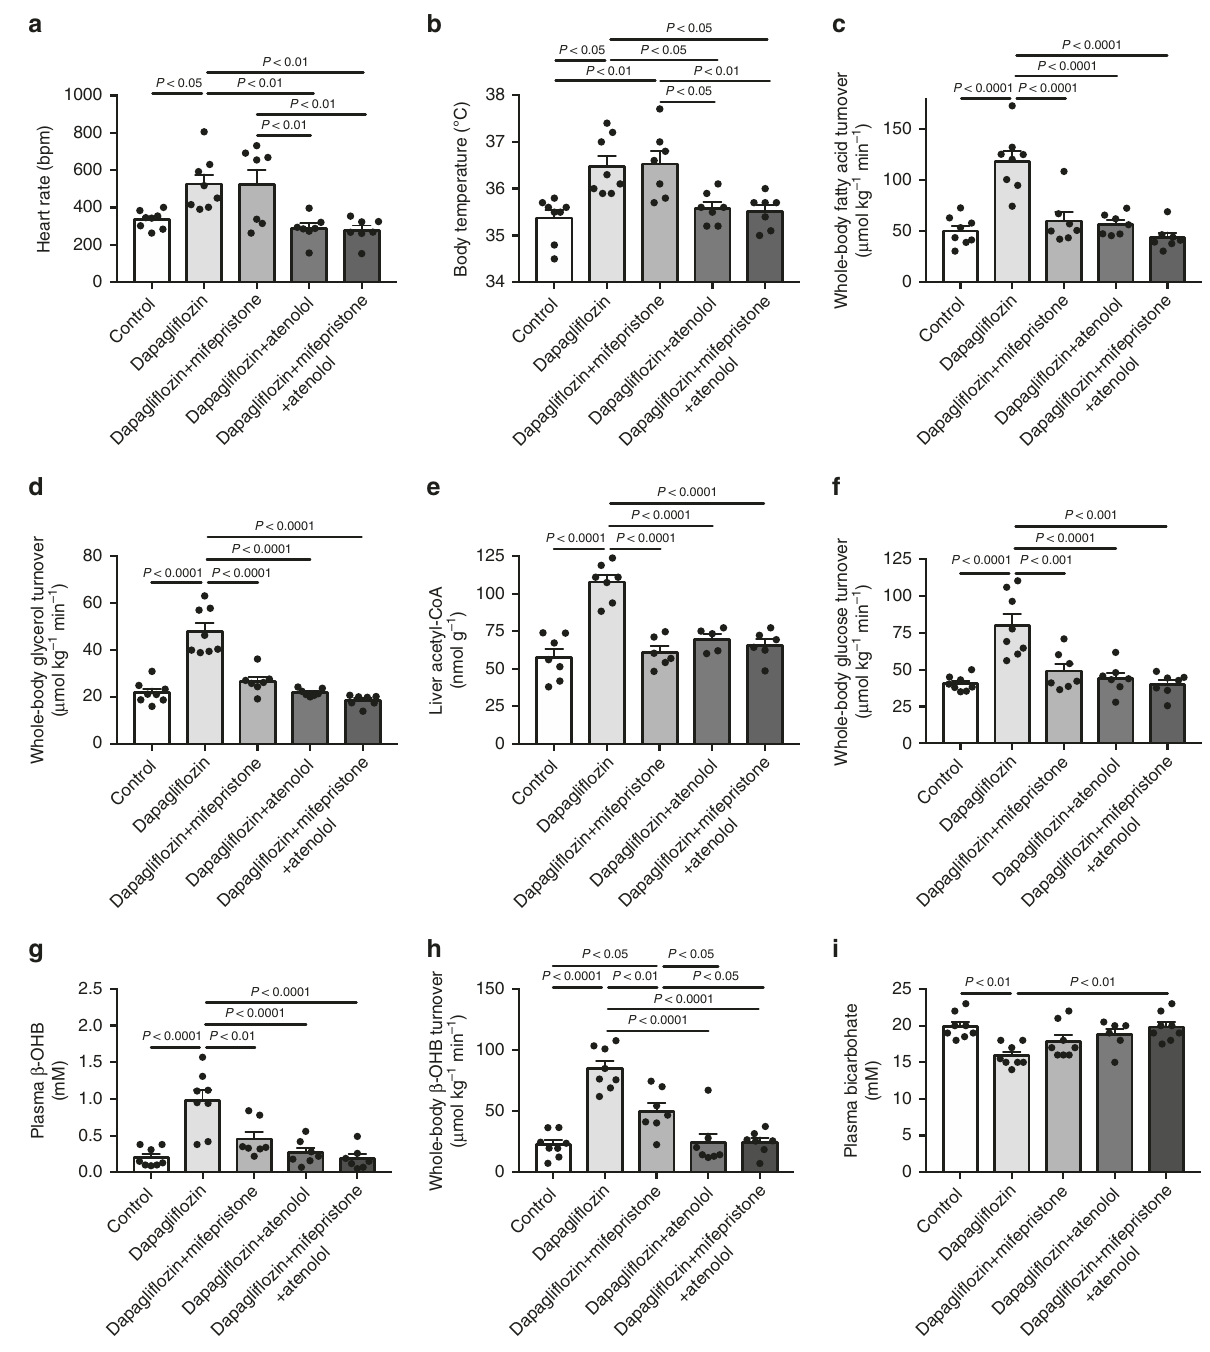
Fig. 4 Dapagli fl ozin causes ketoacidosis in normal rats through β -1 adrenergic and glucocorticoid activity. a , b Heart rate and body temperature after treatment with dapagli fl ozin ± atenolol ± mifepristone. c , d Whole-body fatty acid and glycerol turnover. e Liver acetyl-CoA content. f Whole-body glucose turnover. g , h Plasma β -OHB concentrations and β -OHB turnover. i Plasma bicarbonate. In all panels, data are the mean ± S.E.M., with comparisons by ANOVA with Bonferroni ’ s multiple comparisons